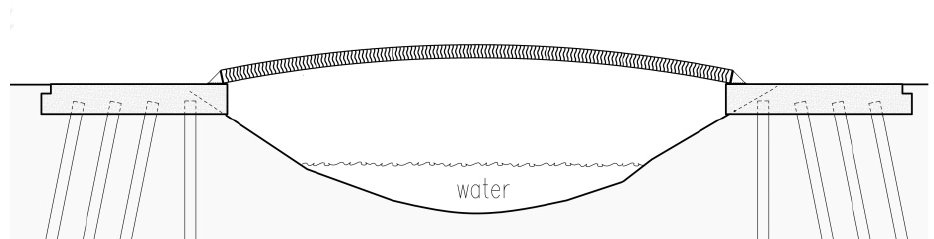
Fig. 1 Schematic representation of glass masonry bridge TU Delft